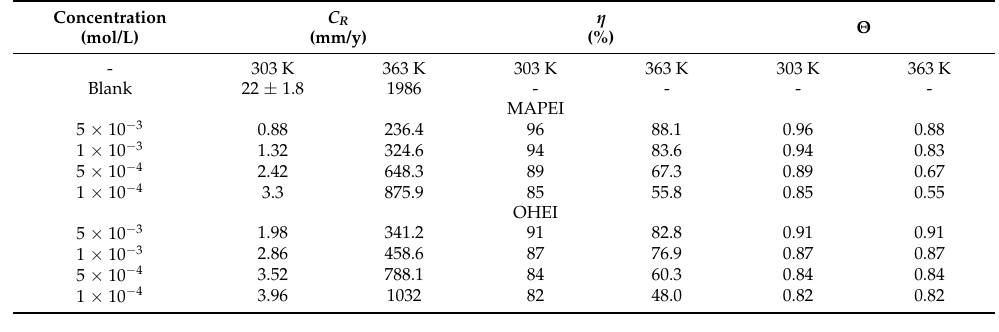
Table 1. Effect of MAPEI and OHEI concentrations on the corrosion data of N80 steel in 15% HCl at 303 K and 363 K.